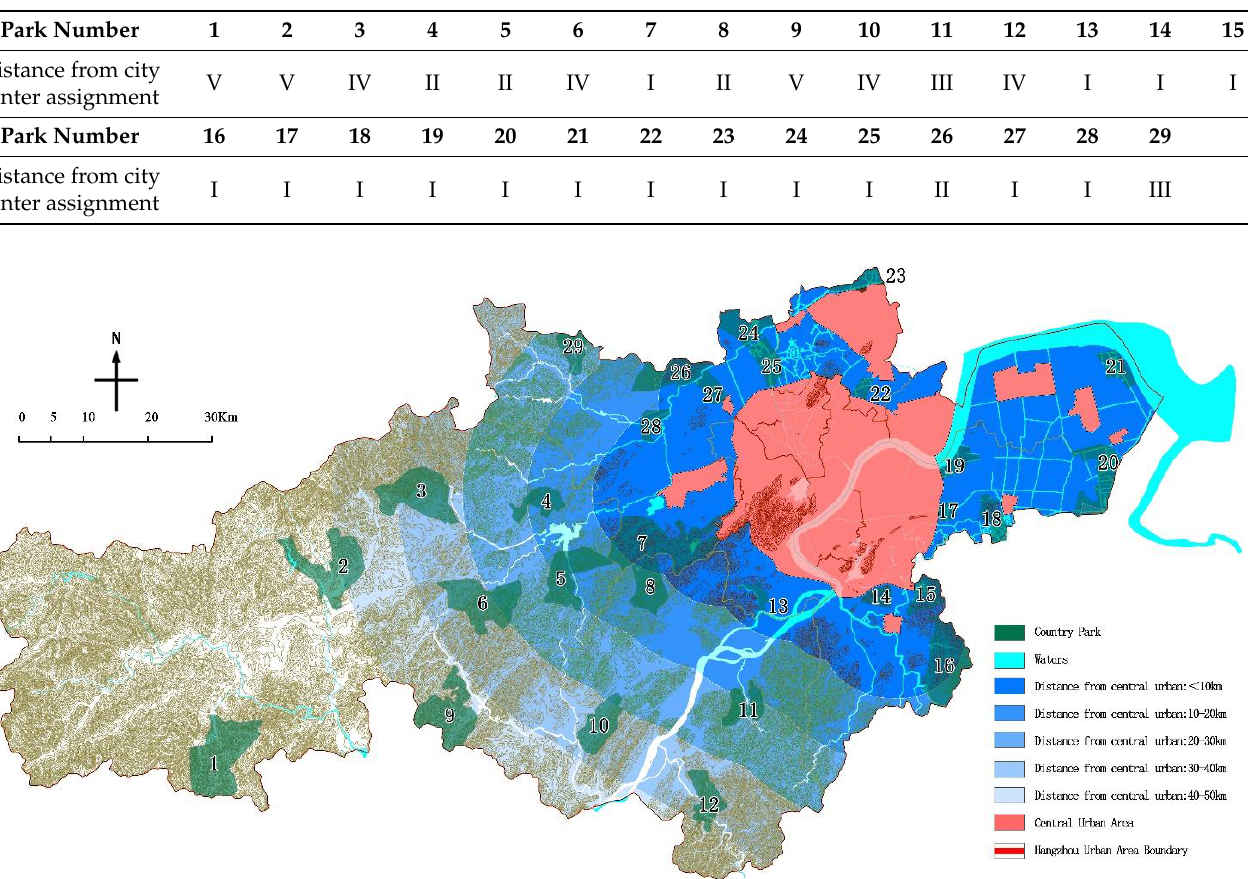
Table 13. The results of distance assignment of country parks from city center.